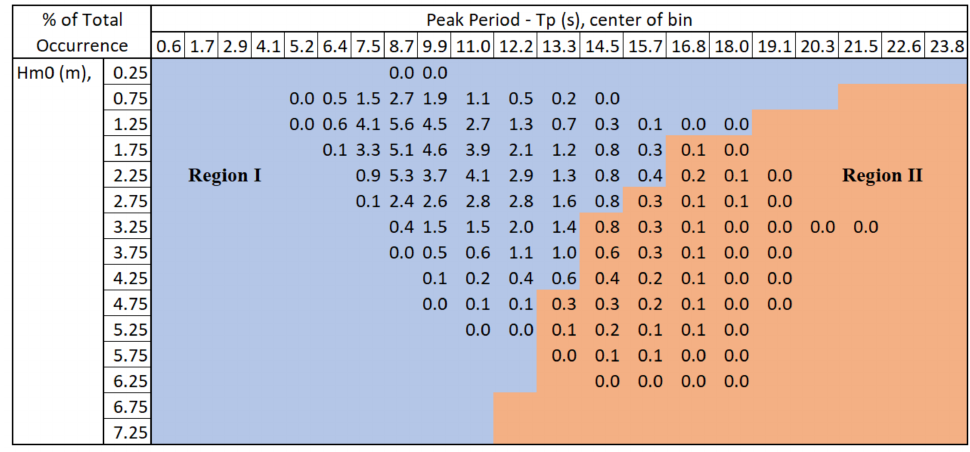
Figure 8. Percentage of total occurrences overlaid on operating region-SANDIA